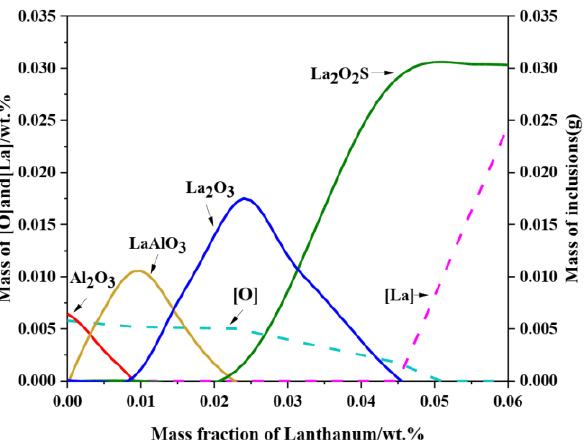
Figure 14. Stability diagram of inclusion predominance region in steel with different La contents at 1600 °C.